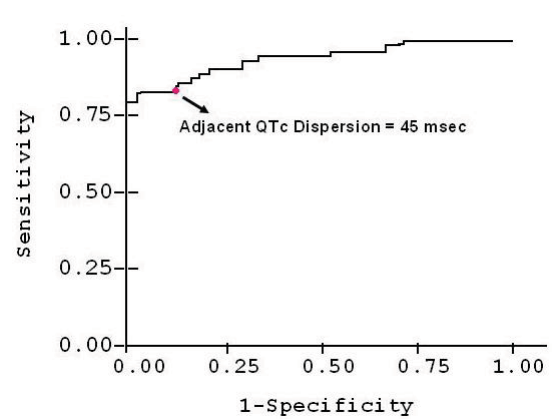
Table 2. Adjacent QTc dispersion in patients with and without ventricular arrhythmias. With